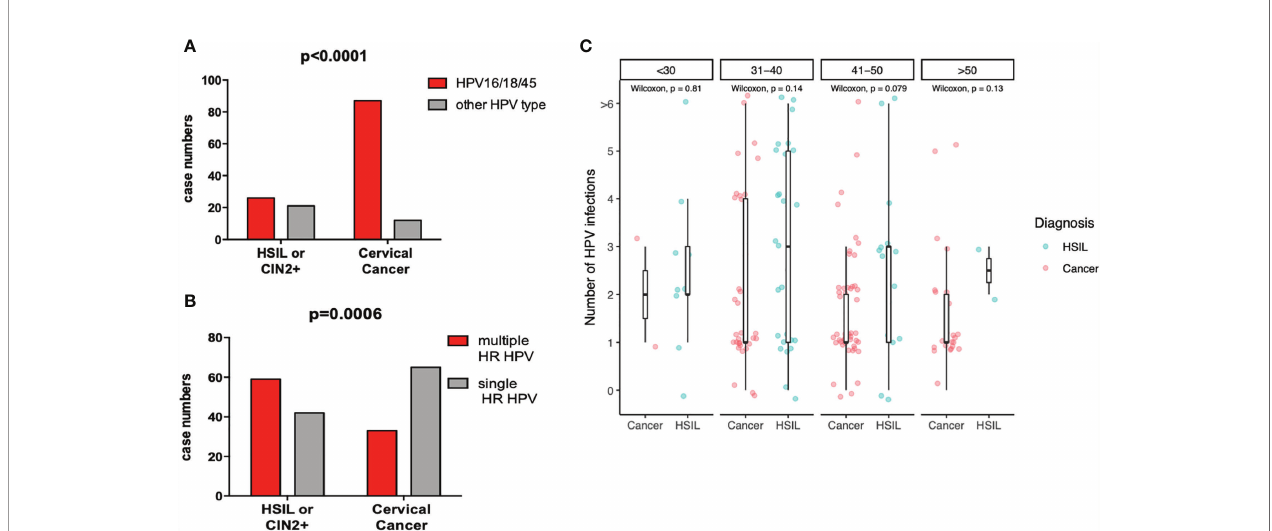
FIGURE 4 | Decreased HPV type diversity and shifting HPV genotype distribution in HIV+ women with cervical cancer. (A) shows the number of subjects with HSIL and cervical cancer cases that were associated with HPV16, 18, or HPV45 infection (red bars) versus those that were not (gray bar) and (B) those associated with multiple HR-HPV types versus single HR-HPV types. Indicated p-values were calculated using the two-sided Fisher ’ s exact test. (C) shows the number of HPV types detected in HIV + women with cervical cancer or HSIL in different age groups. Statistical analyses were performed by Wilcoxon